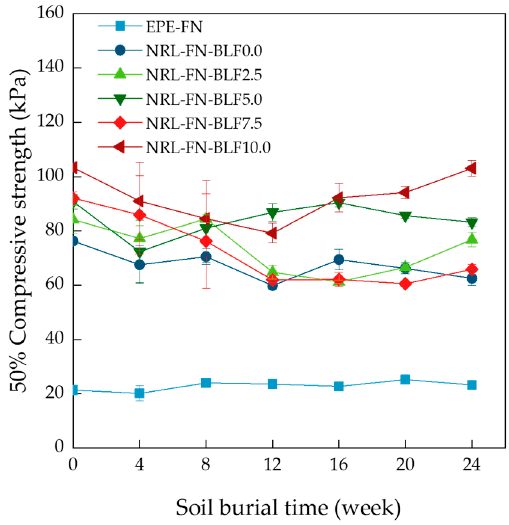
Figure 17. Compressive strength of 50% of cushion foam at various soil burial times .